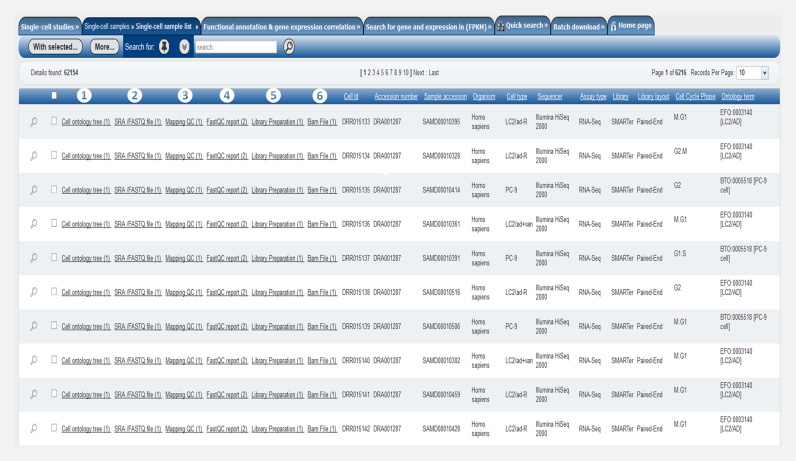
Single-cell samples view. This figure shows the elements of the single-cell sample view. Each sample has a set of attributes and links. (1) The links lead to a cell ontology tree and (2) SRA/FASTQ files on external sites. The ‘Cell ontology tree’ directs to the EBI ontology lookup services (OLS) via web service. The ‘SRA/FASTQ file’ link opens a page for downloading sequence reads files. Other types of links enable direct file downloads, or lead to reports from SCPortalen (e.g. (4) FastQC report, (6) BAM files). Finally, (3) mapping QC and (5) library preparation information are listed in the table view. Using the check-boxes in the left side of the menu user will be able to select any number of cell and export the selected ones to CSV or Excel file format.